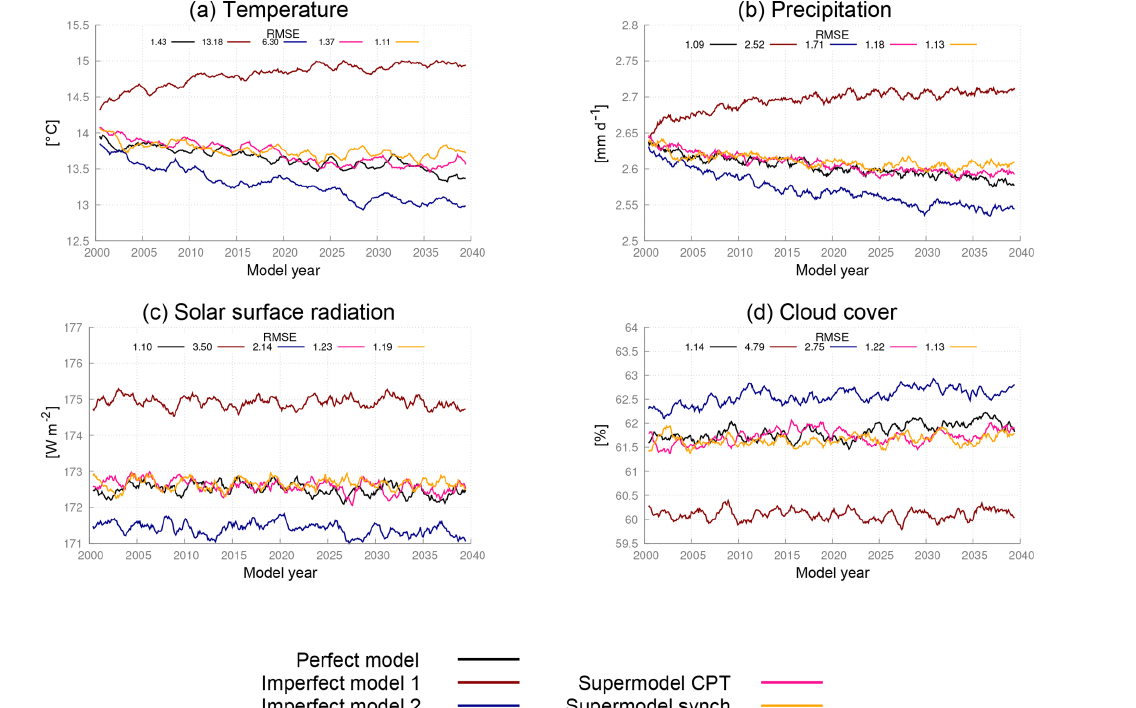
Figure 8. Global mean time series for the perfect model, the imperfect models and the two supermodels trained by CPT and the synch rule. The normalized root mean squared error (RMSE) in the climatology of model years 2011–2040 with respect to the climatology of the truth is given in each panel. The normalization is such that the expected value of the perfect model error is